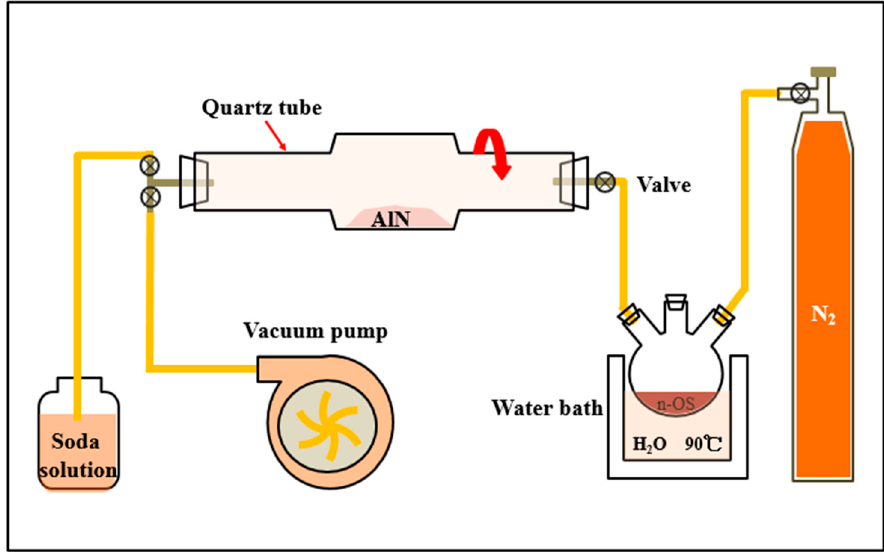
Figure 2. The surface modi fi cation device of AlN